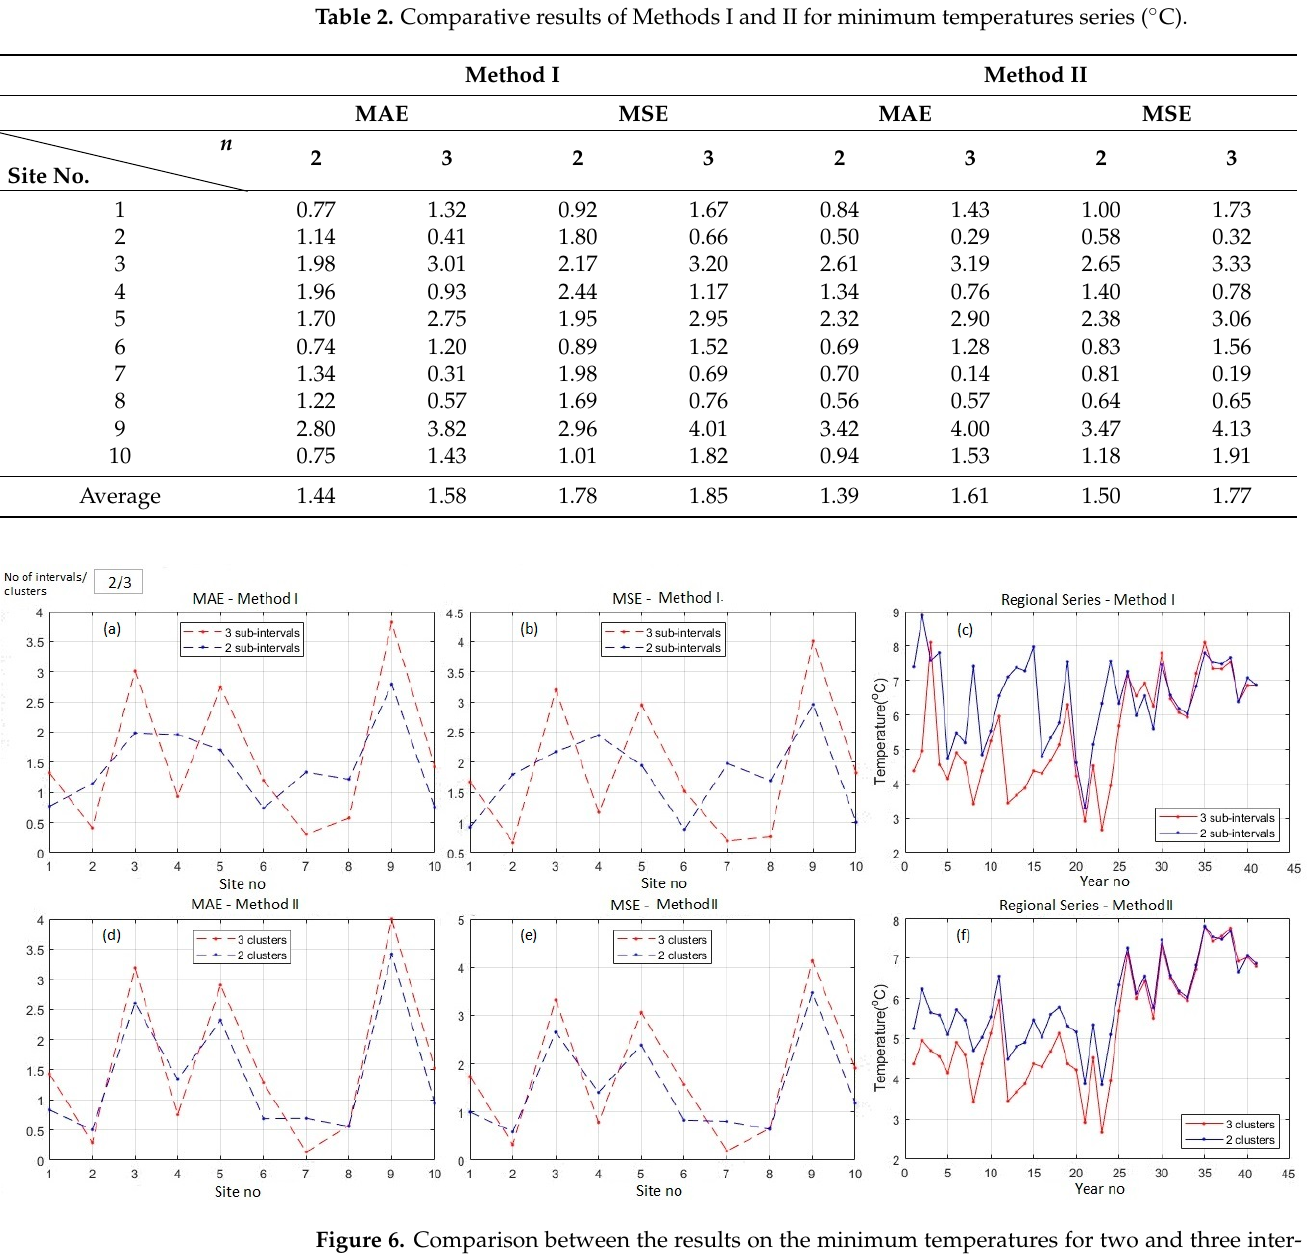
Table 2. Comparative results of Methods I and II for minimum temperatures series ( ◦ C).